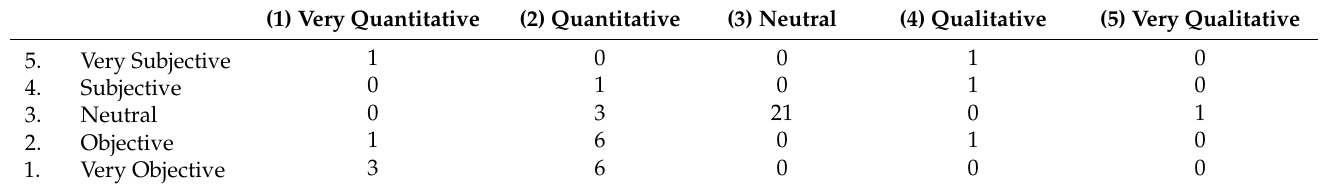
Figure 3. The meta-analytical position of the study’s bibliographical sources on the conceptual model. The sources appear on the model as the surnames of their principal authors. Table 6. Two-way frequency table of sources per subjective/objective and quantitative/qualitative dimension of